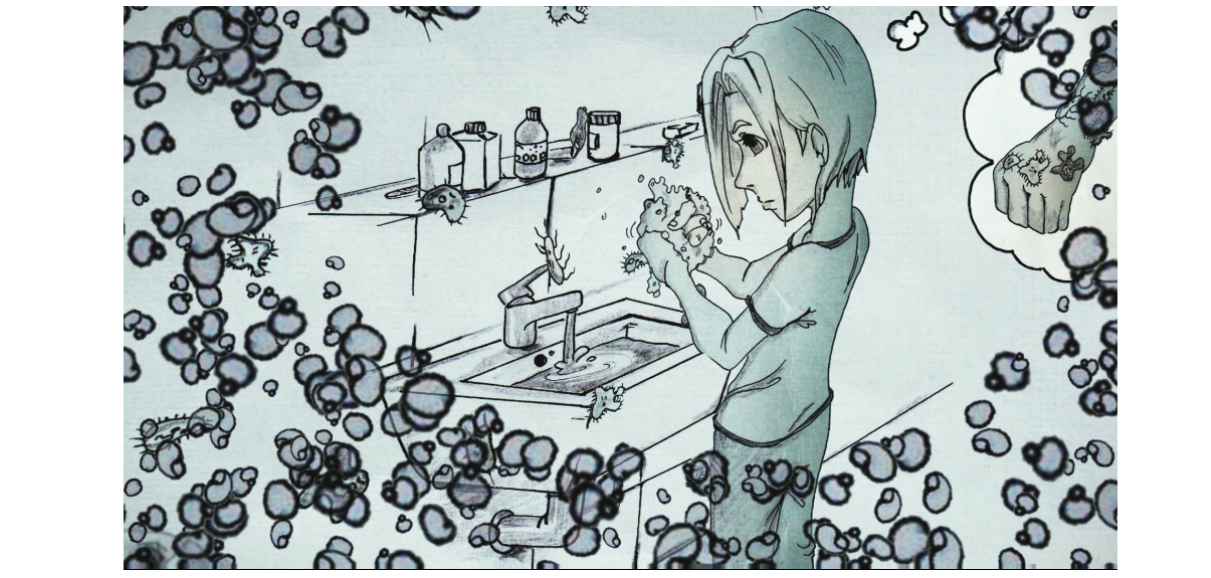
Figure 1. Psychoeducation